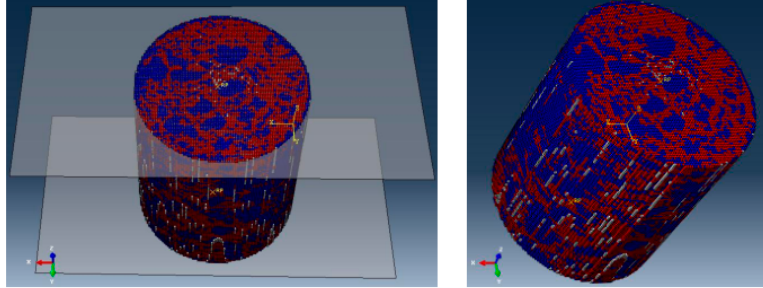
Figure 6. Three-dimensional finite element model of asphalt mixture.